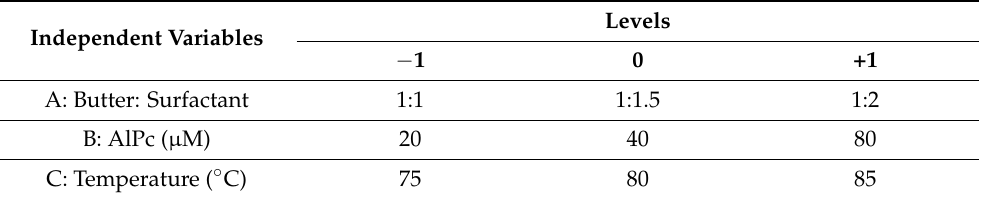
Table 1. Independent variables selected for Box–Behnken method. Independent